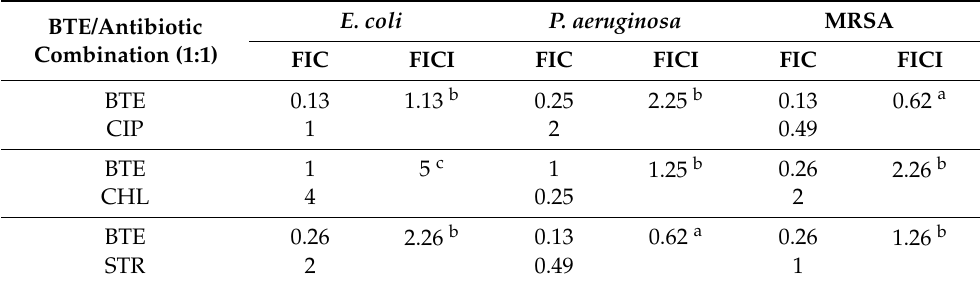
Table 3. Antibiotic potentiating activity of Bruguiera twig ethyl acetate extract (BTE).